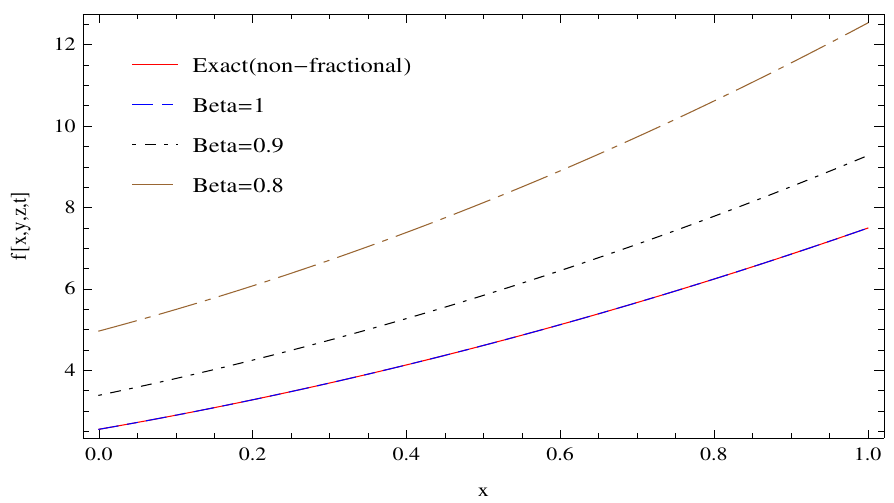
Figure 11. The FRDTM solutions f ( x , y , z , t ) for β = 1,0.9,0.8,0.7 and the exact (nonfractional) solution; x ∈ [ 0,1 ] ; t = 0.1, z = 0.5, and y = 0.5.